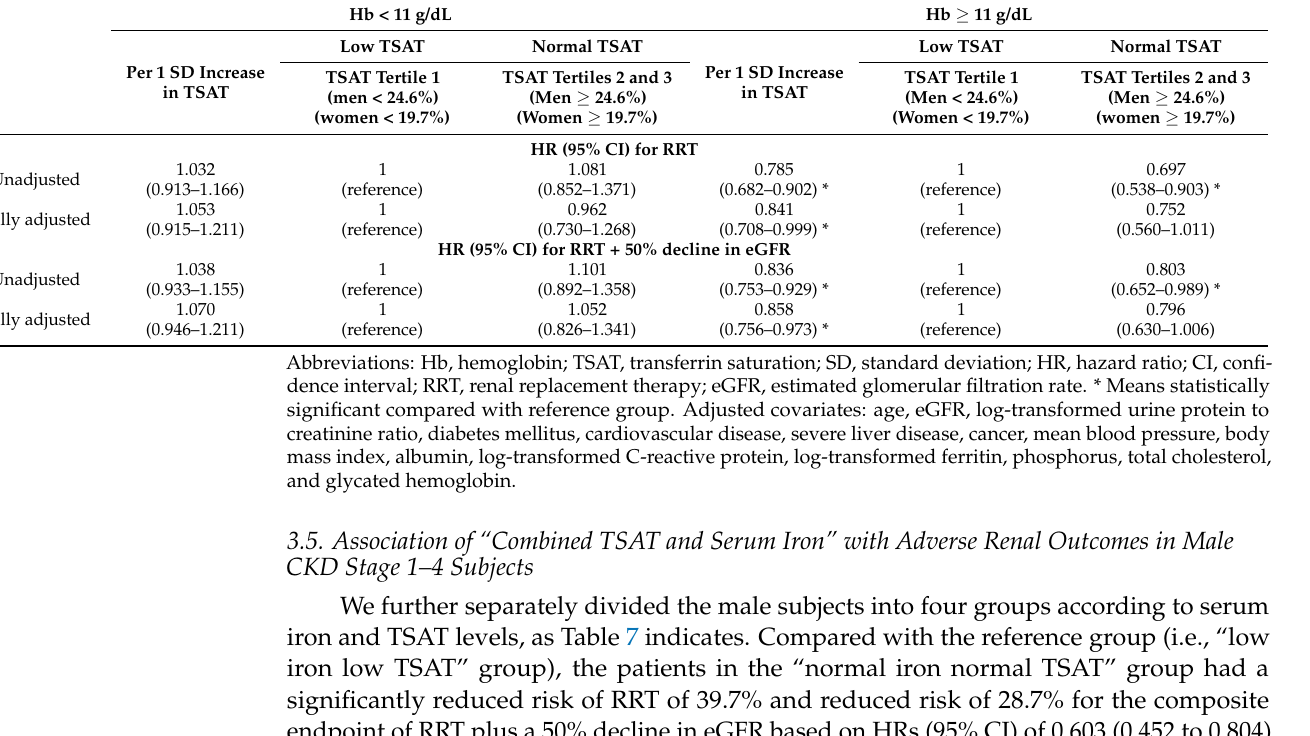
Table 6. Association of TSAT with renal outcomes divided by hemoglobin. Hb < 11 g/dL Hb ≥ 11